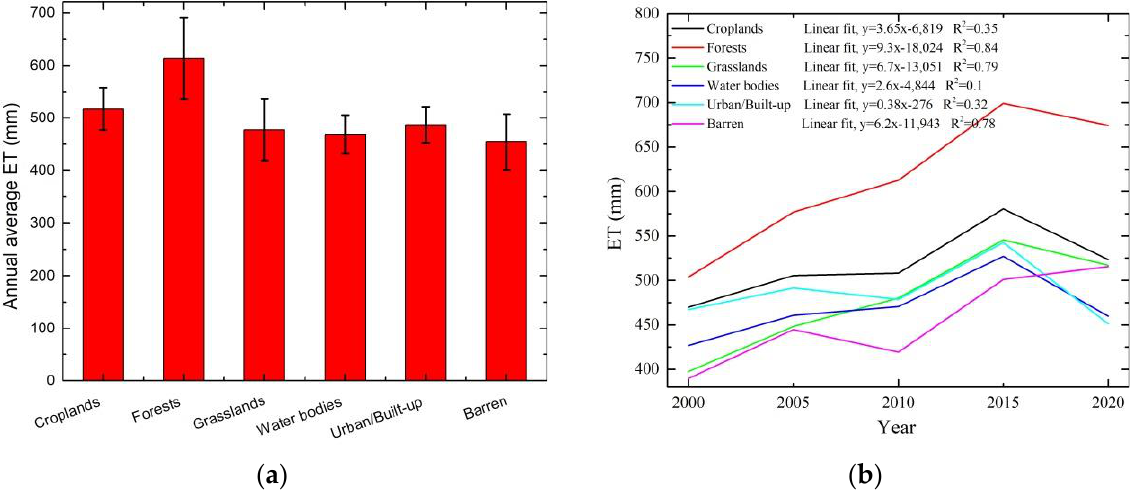
Figure 13. Change trends of different land-use type areas from 2000 to 2020.